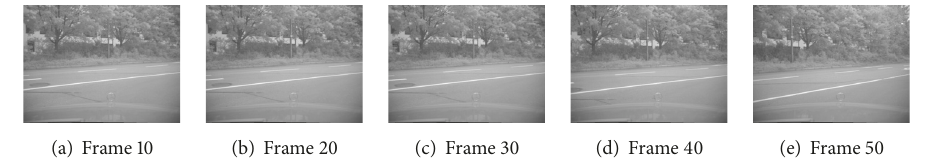
Figure 13: Image samples from the left camera (Crazy turn).